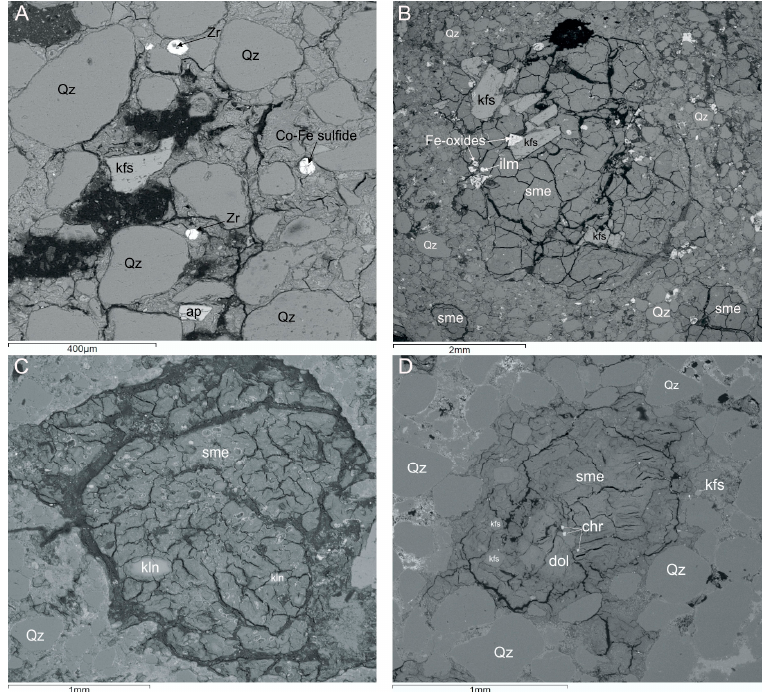
Figure 6. Back-scattered electron images of thin section of sandstones from the KL-01 pipe ( A – C ) and Suksoma olivine melilitite/picrite pipe ( D ). Qz = quarts, kfs = K-feldspar, Sme = smectite, Zr = zircon, Ap = apatite, ilm = ilmenite, kln = kaolinite, dol = dolomite, chr = Cr-spinel. Abbreviations of minerals according to [26].